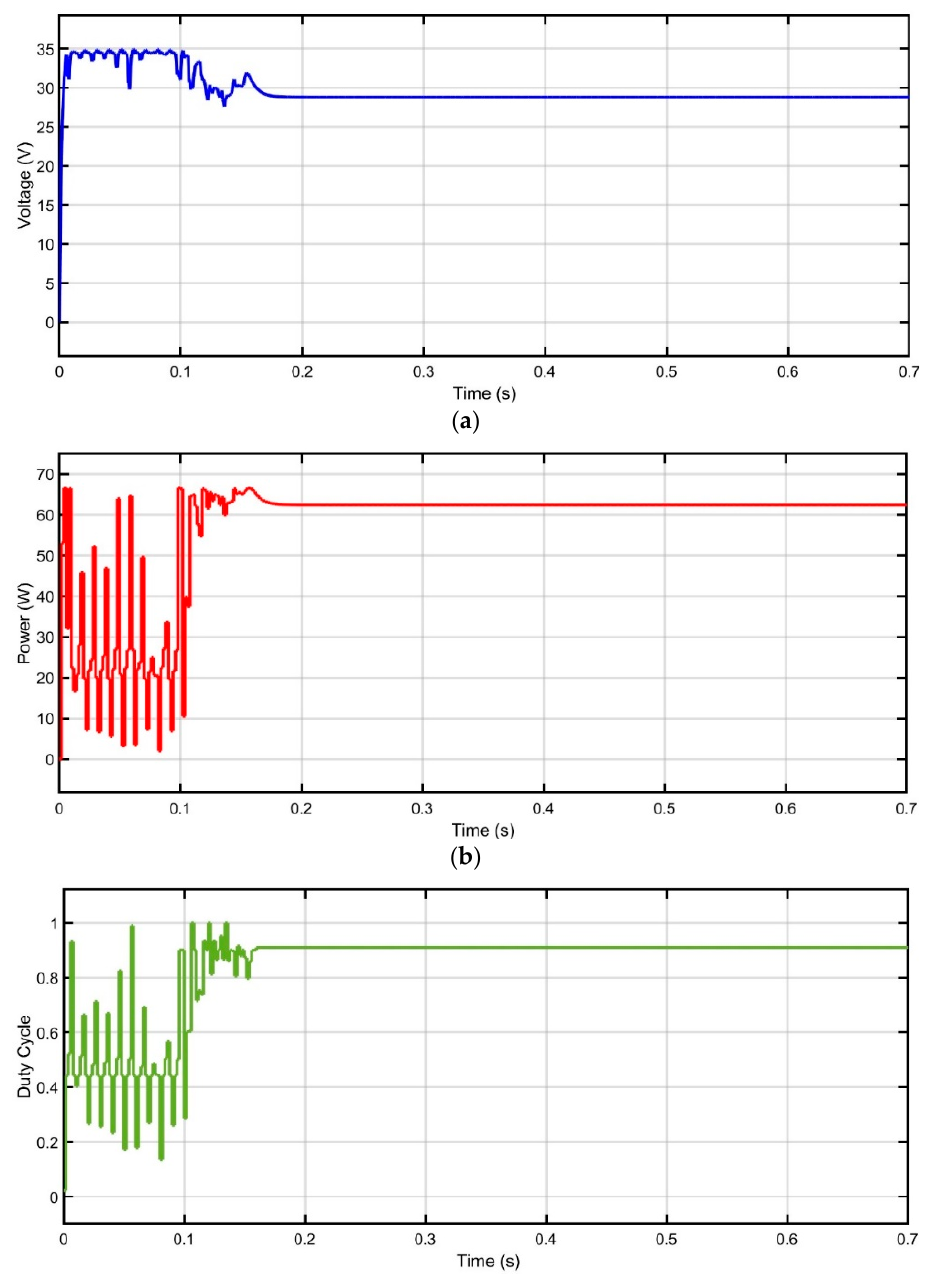
Figure 15. ( a ) The voltage, ( b ) the power, and ( c ) the duty cycle using the cuckoo search method.